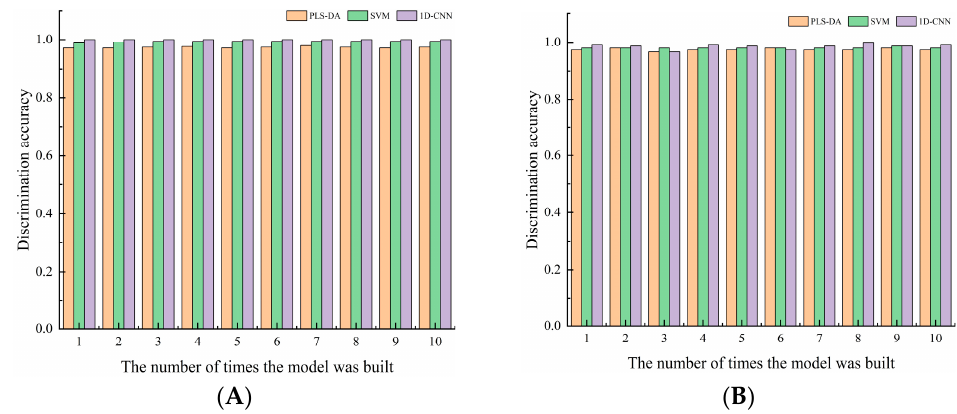
Figure 8. Discrimination accuracy of training sets and test sets in 10 PLS-DA, SVM, and 1D-CNN models: ( A ) training sets; ( B ) test sets. Table 5. Statistics of test results of SVM, PLS-DA, and 1D-CNN models.